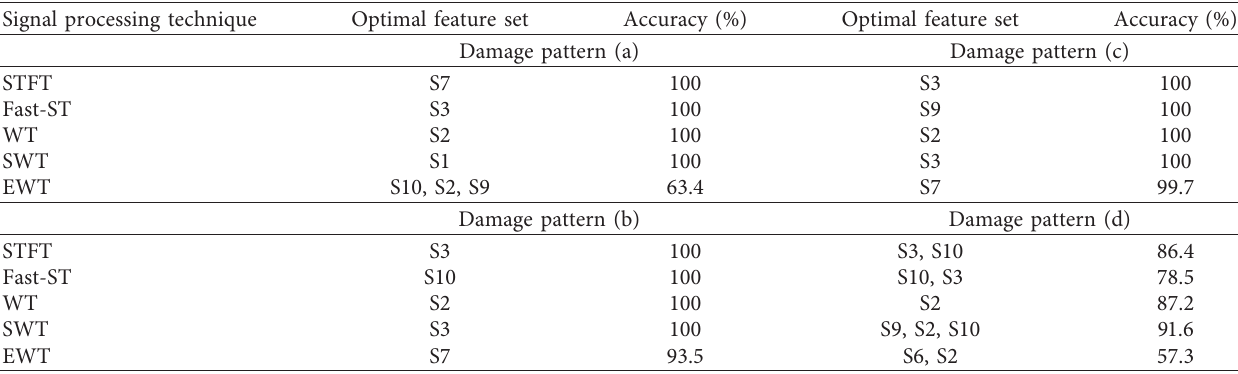
Table 6: Classification accuracy of the selected feature subset obtained by using different feature extraction methods for the IASC-ASCE SHM benchmark structure (for sensor 2).